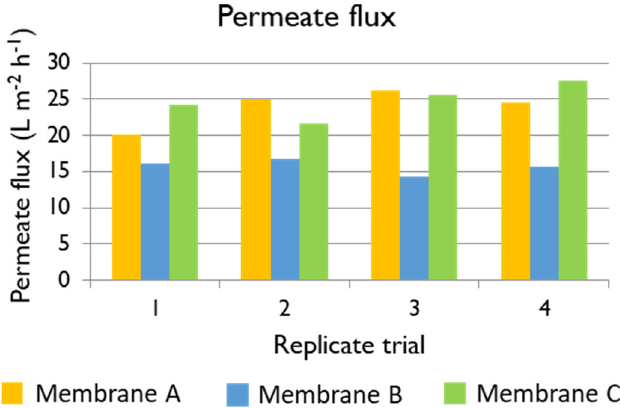
Figure 10. Permeate fluxes in experiments with black liquor with membranes A, B, and C.